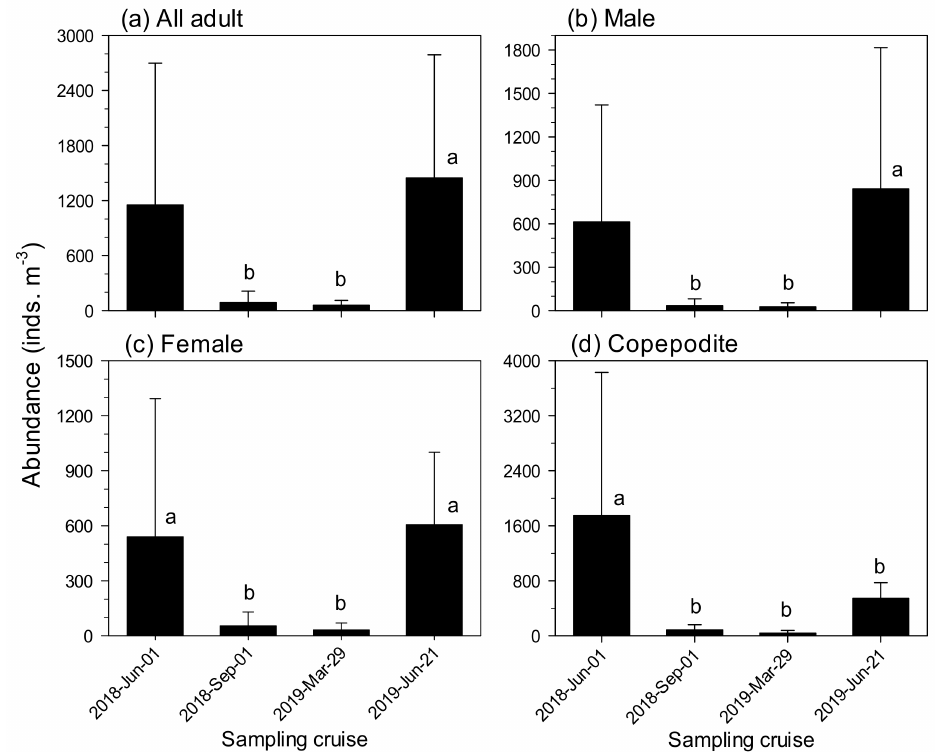
Figure 6. The abundance of all adults ( a ), males ( b ), females ( c ), and copepodites ( d ) of Temora turbinata throughout four samplings from June 2018 to June 2019 by using one-way analysis of variance, followed by Tukey test. Significant differences are indicated by different superscripts ( p < 0.05) among the sampling months in the waters off Northeast